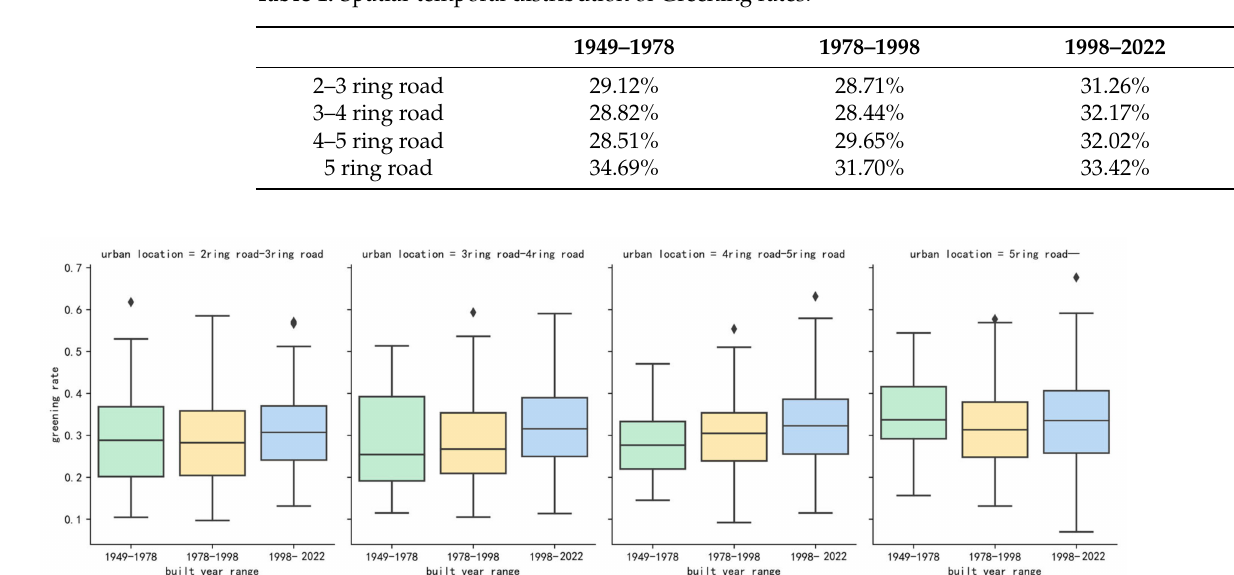
Table 1. Spatial-temporal distribution of Greening rates.